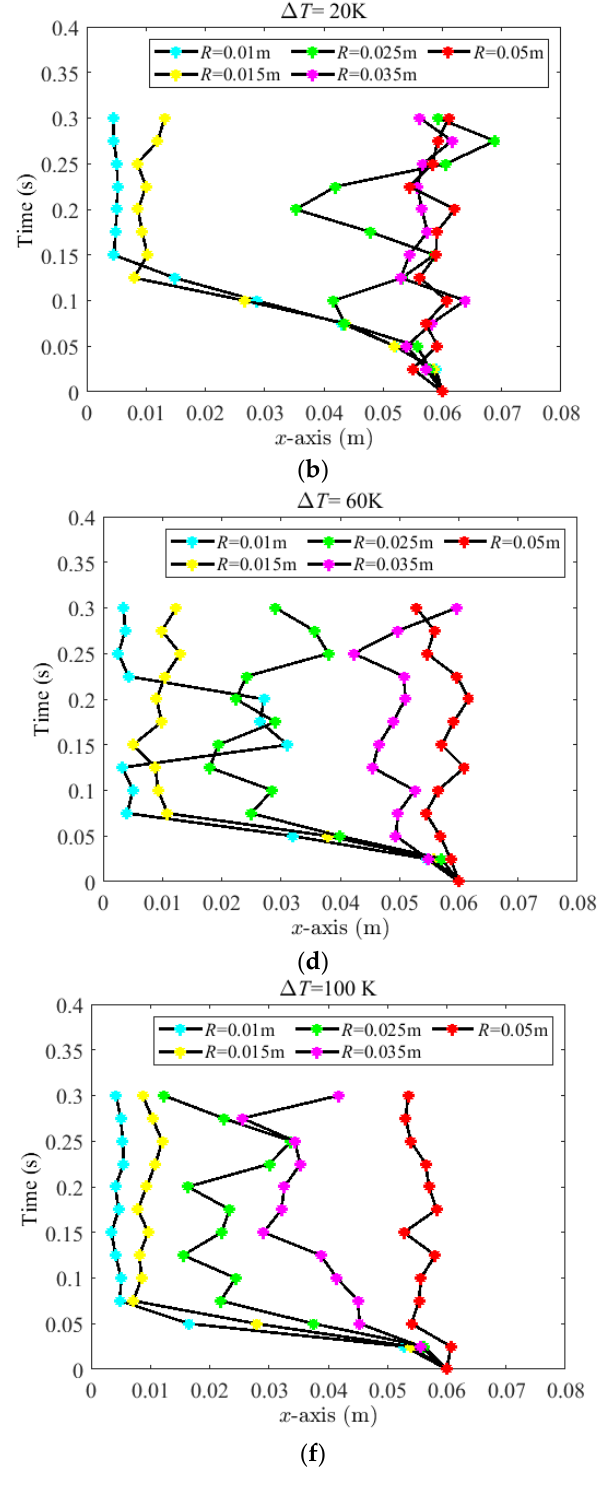
Figure 3. Schematic representation of the movement of the bubbles with different bubble radii in the x -direction under different longitudinal temperature gradients ( a ) ∆𝑇 = 0 K, ( b ) ∆𝑇 = 20 K, ( c ) ∆𝑇 = 40 K, ( d ) ∆𝑇 = 60 K, ( e ) ∆𝑇 = 80 and ( f ) ∆𝑇 = 100 K.